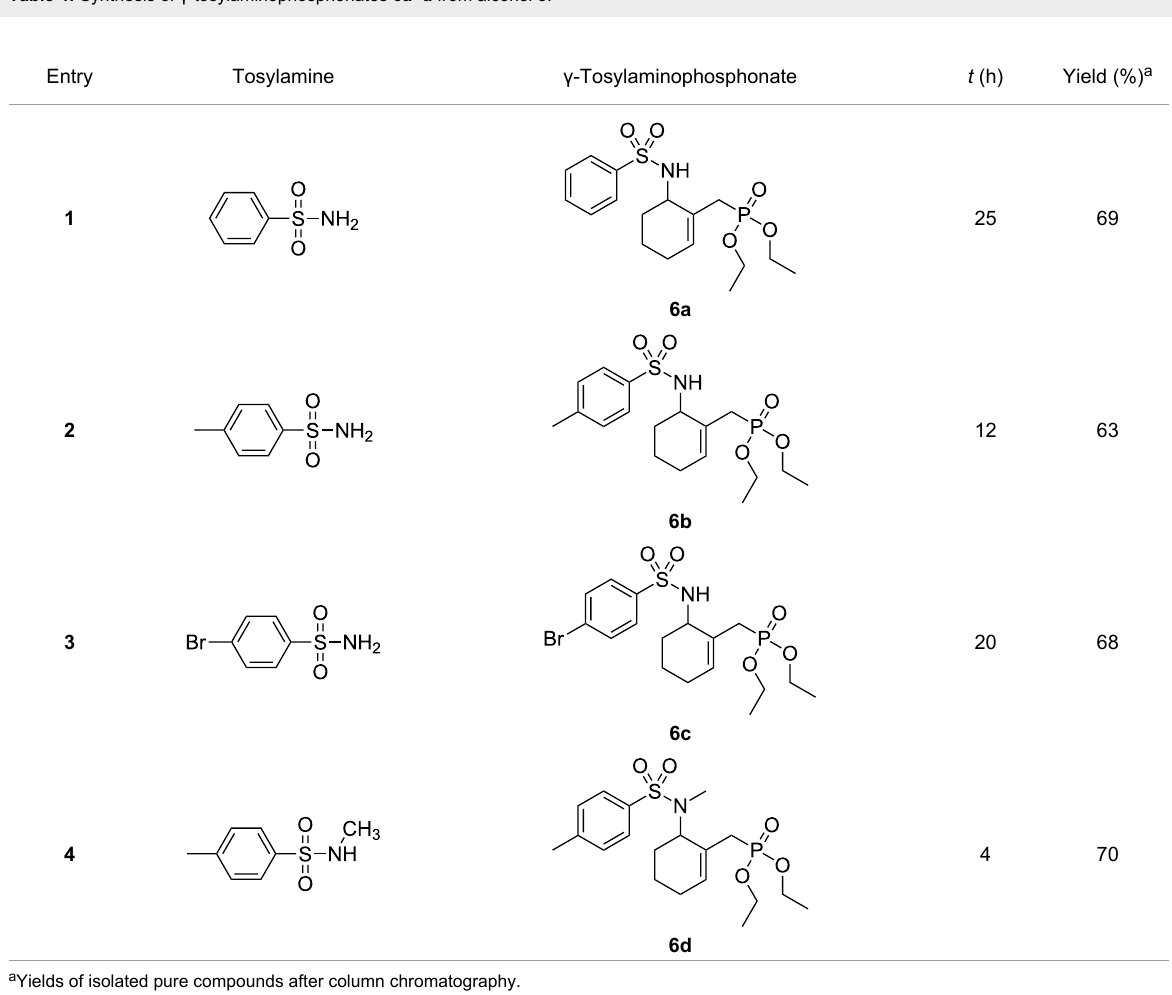
Table 4: Synthesis of γ -tosylaminophosphonates 6a–d from alcohol 5